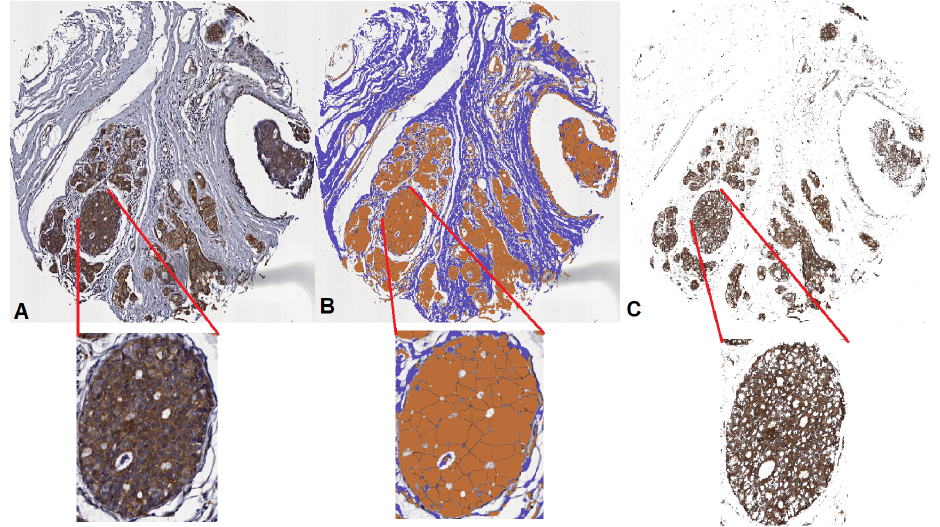
Figure 6. Comparison between immunoRatio and NUBIA Wnt-1 1Ratio: ( A ) original TMA tissue core image; ( B ) ImmunoRatio results; and ( C ) NUBIA Wnt-1 1Ratio